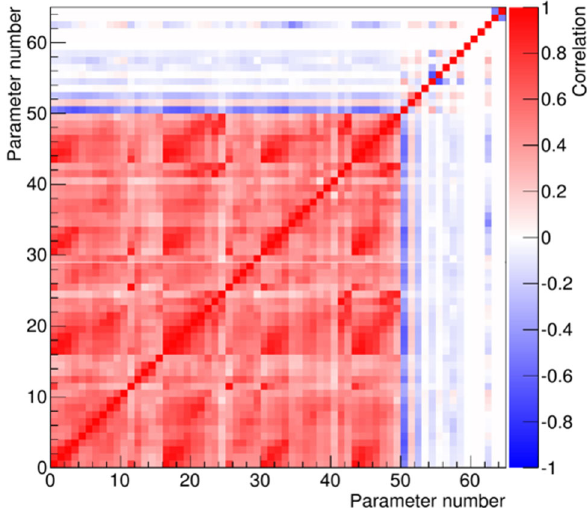
Fig. 64 The correlation matrix of the SK flux and cross section param- eters. Parameters 1 ∼ 25 correspond to the ν μ flux (1–11), ν μ